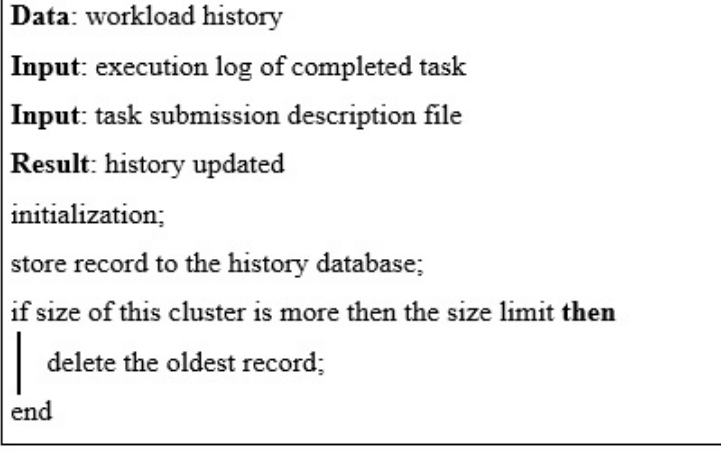
Figure 4. History management algorithm.